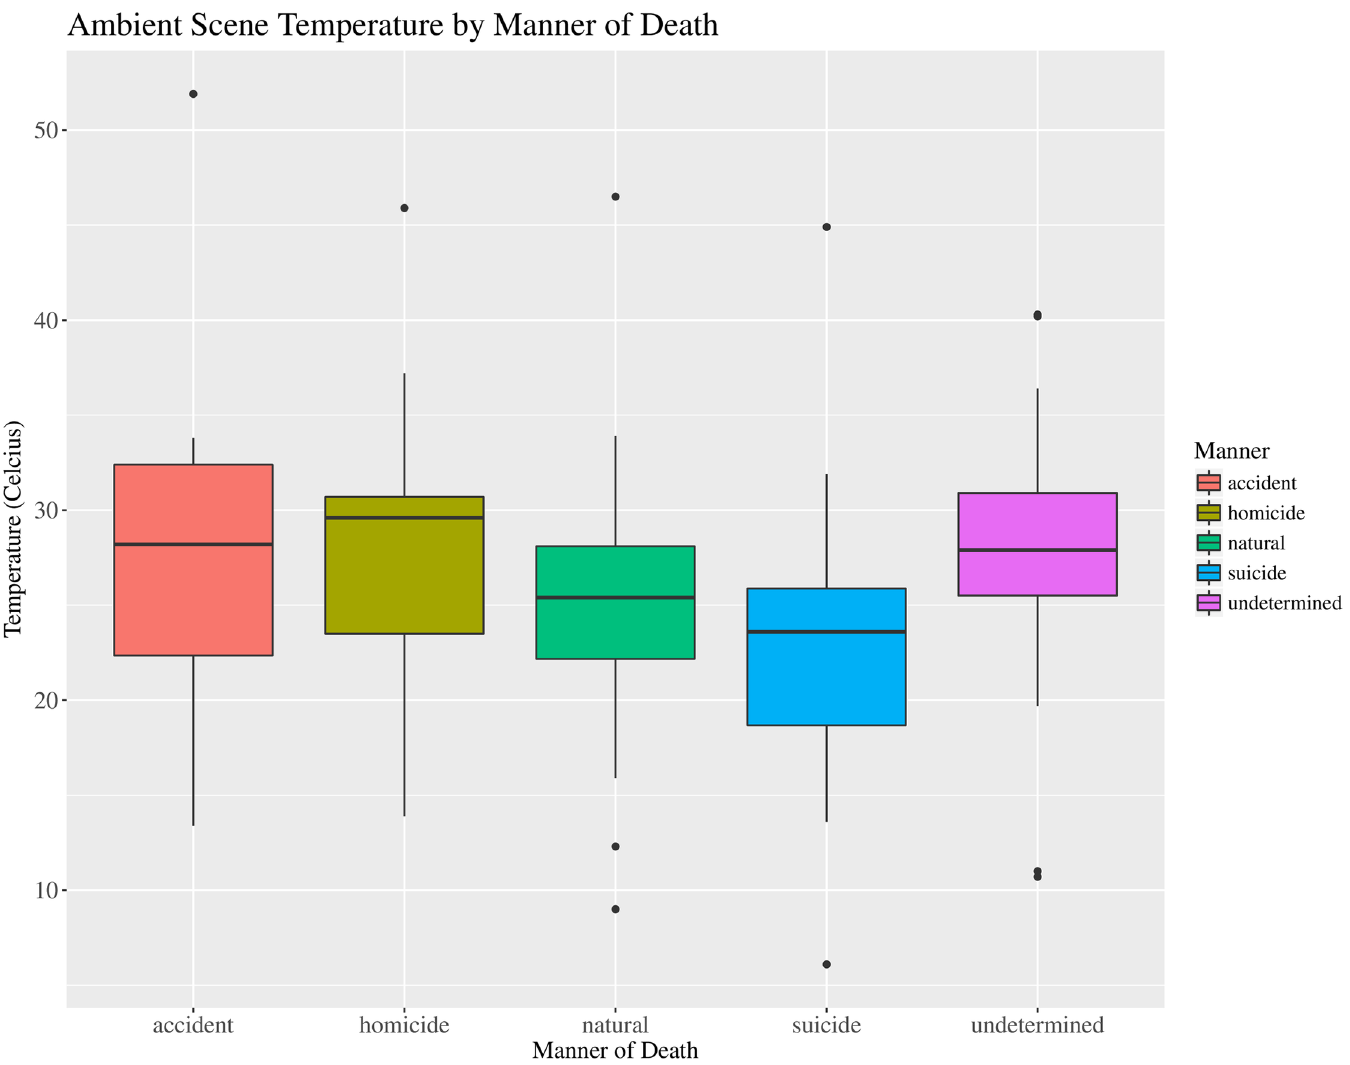
Fig 3. Boxplot of median ambient scene temperature (˚C) by manner of death. Boxplot illustratingthe medianambient air temperature (˚C) and associatedvariationrecordednear the decedentat scenes by the Mannerof death classification for forensic entomology cases over the study period (January 2013–April 2016). (N =